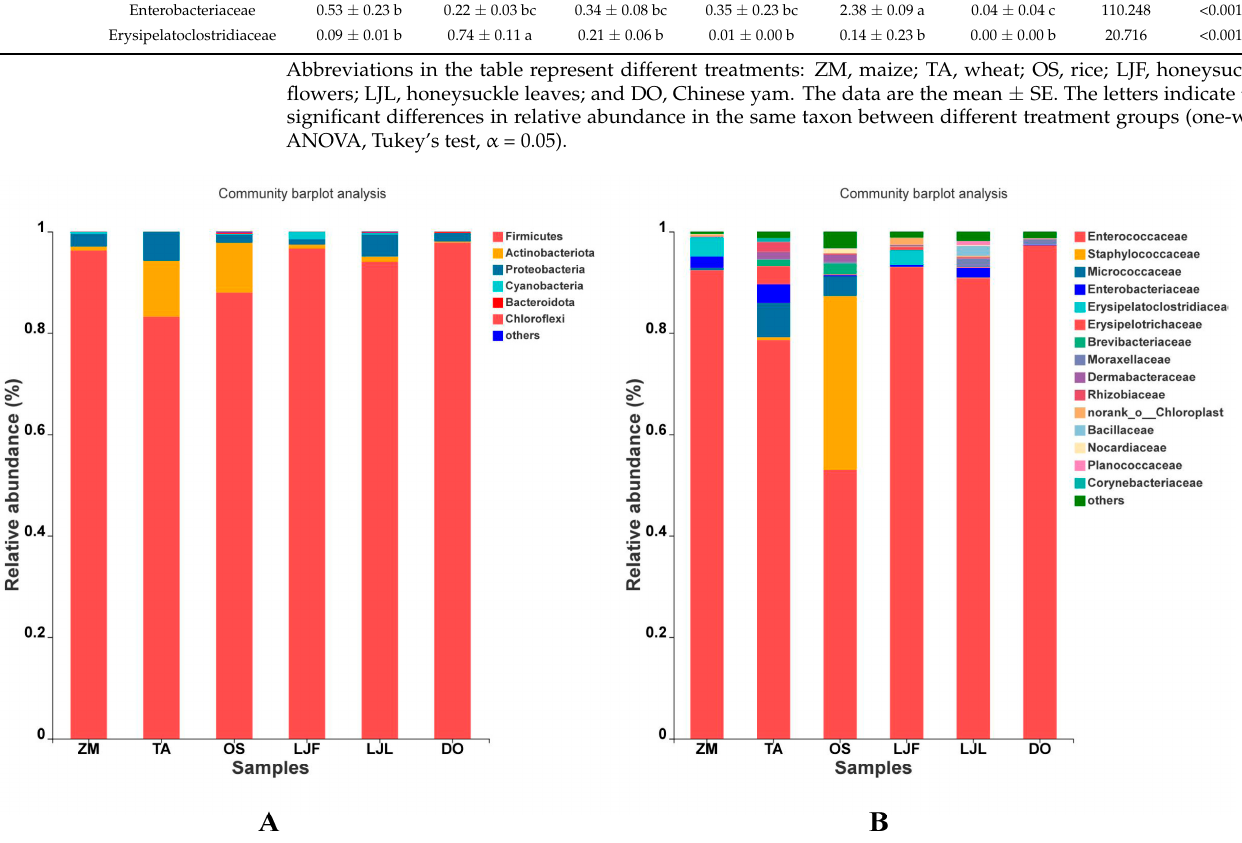
Figure 2. The relative abundance of dominant bacteria in Spodoptera frugiperda fed on different hosts. ( A ) phylum levels; ( B ) family levels. Abbreviations in the figure represent different treatments: ZM, maize; TA, wheat; OS, rice; LJF, honeysuckle flowers; LJL, honeysuckle leaves; and DO, Chinese yam.